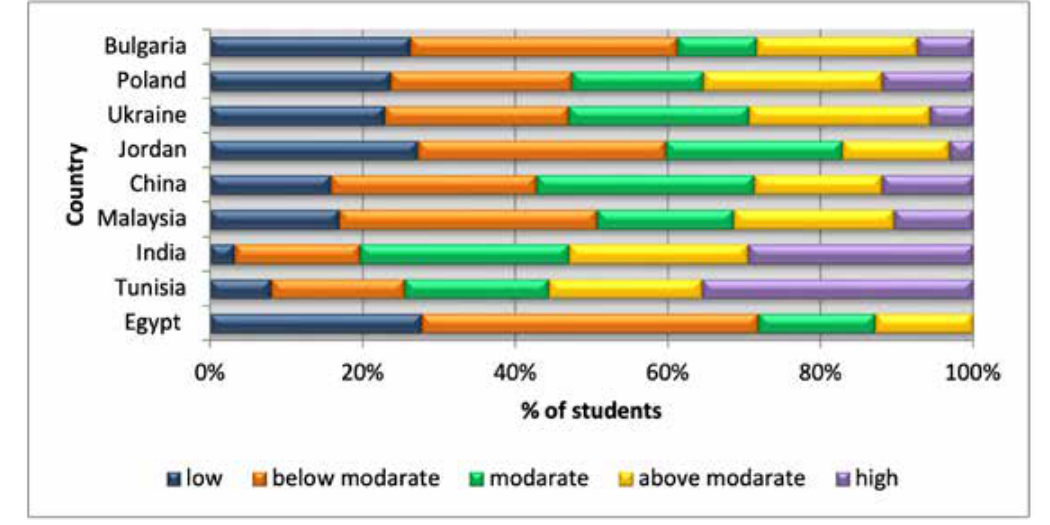
Figure 2. Distribution by levels of cardiorespiratory endurance of students